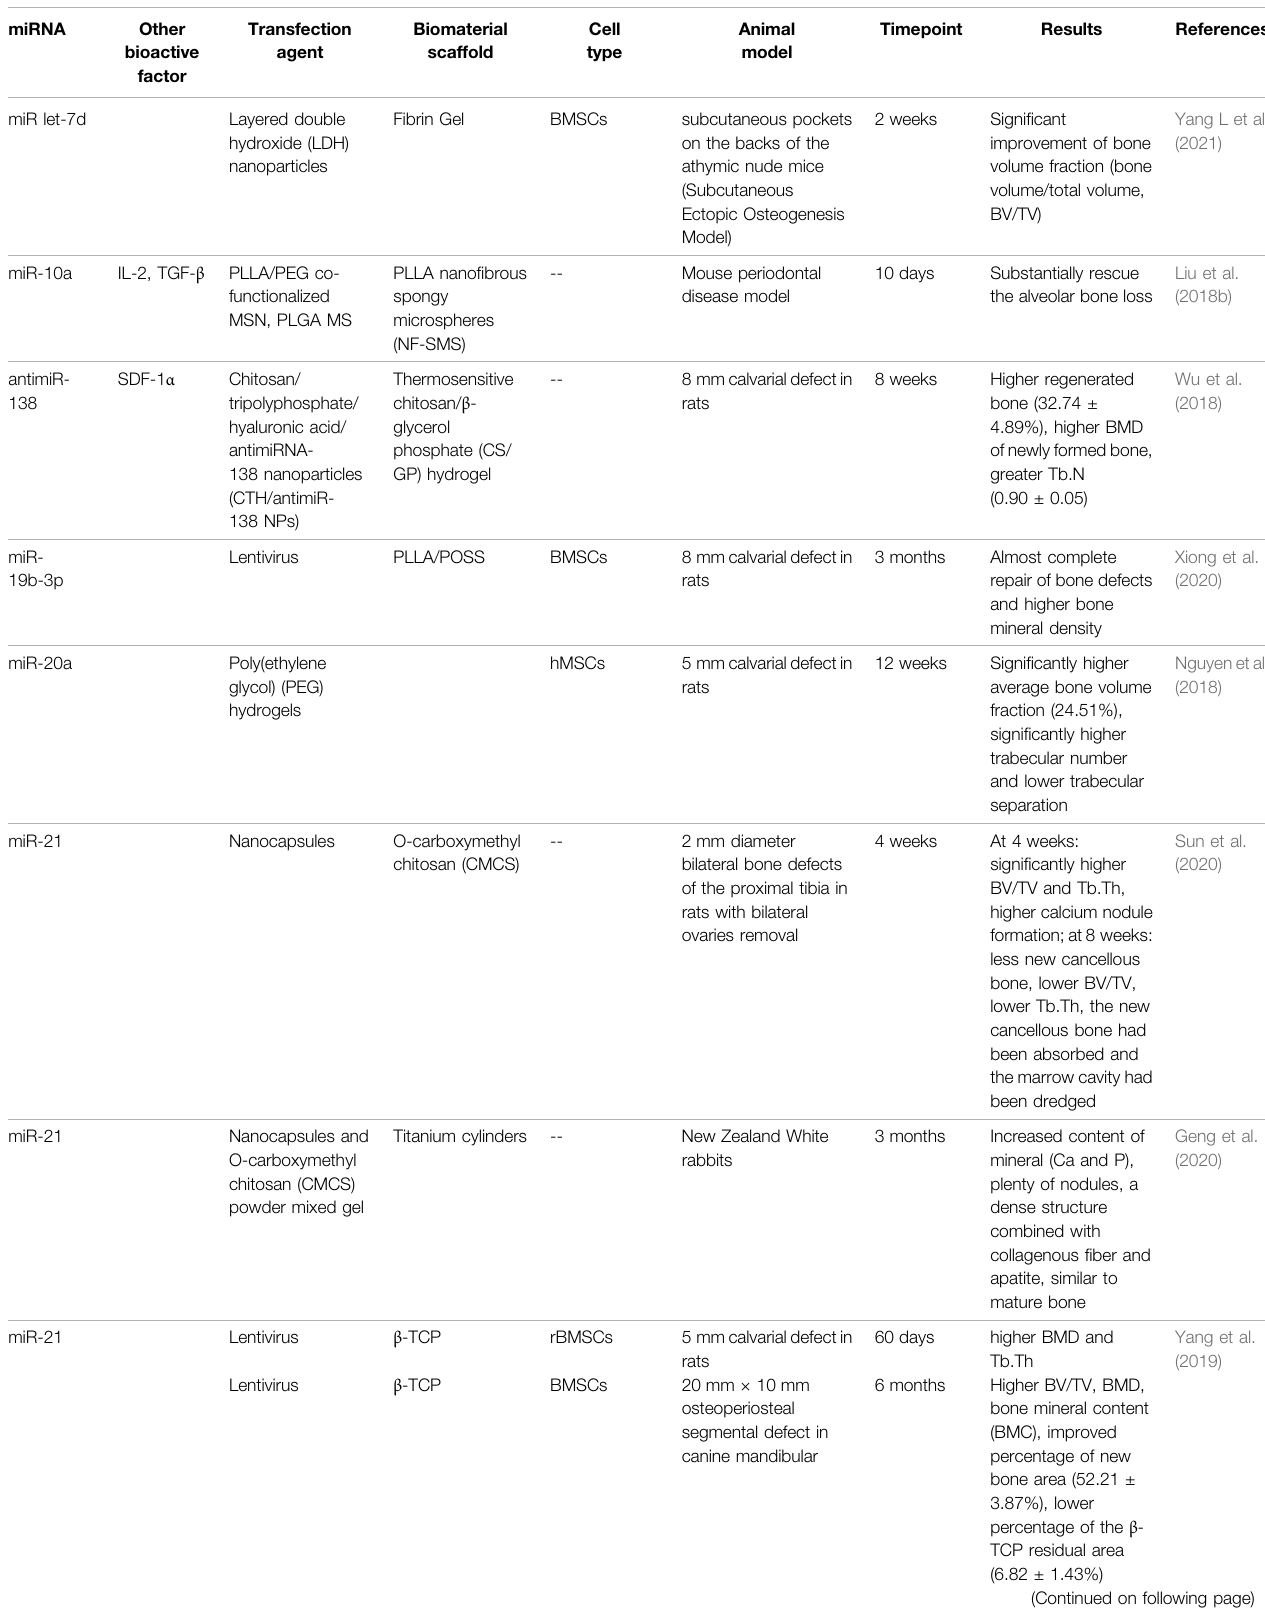
TABLE 1 | The application of miRNAs in bone tissue engineering in vivo